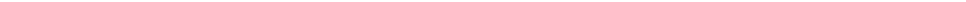
(See figure on next page.) Fig. 6 c-Fos activation map of cortical structures in the LEV-induced chronic migraine model. A . Representative pictures of c-Fos (red) and NeuN (green) immunofluorescence labeling in the mPFC. Scale bars the percentage of c-Fos + cells in NeuN + cells ( C ). alleviated by olcegepant. n (green) immunofluorescence labeling in the ACC. Scale bars the percentage of c-Fos + cells in NeuN cells ( F ) were found. n Abbreviations: mPFC, medial prefrontal cortex; ACC, anterior cingulate cortex; OLC, olcegepant; LEV,